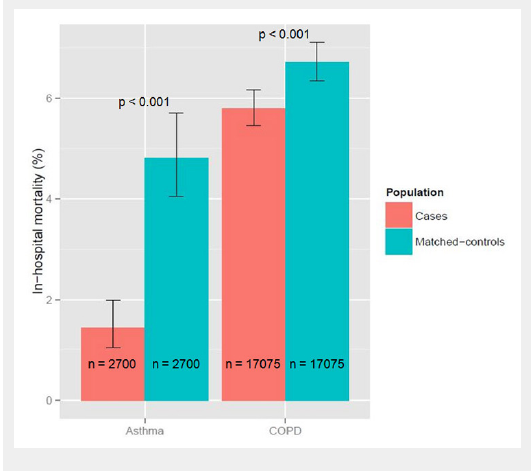
In-hospital mortality of hospitalised COPD and asthma patients compared to their matching controls without lung